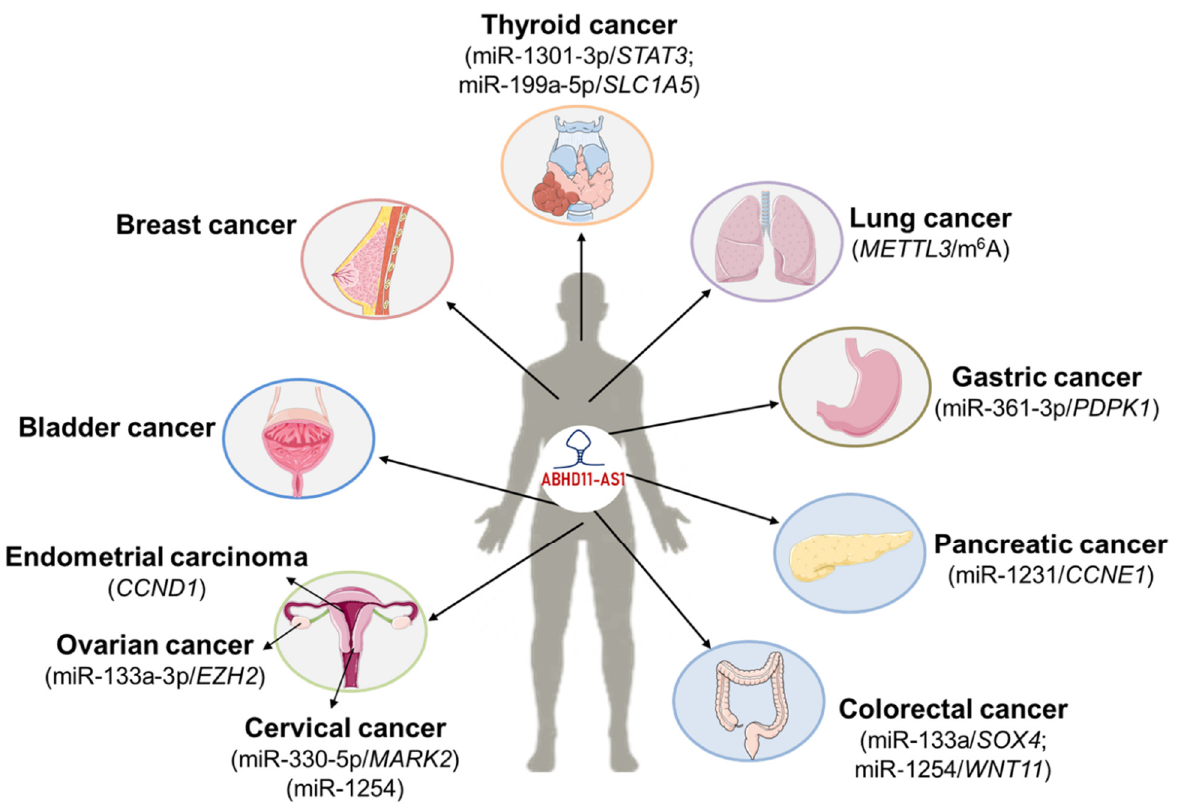
Figure 5. The role of ABHD11-AS1 lncRNA in the development and prognosis of different malignant tumors. The potential targets of ABHD11-AS1 in the progression of cancers were indicated. The artworks were adopted from https://smart.servier.com/ (Accessed on 14 October 2021).